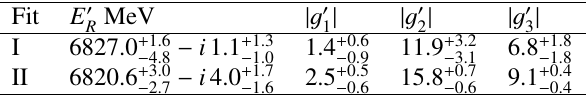
Table 6. Pole position and couplings of the X